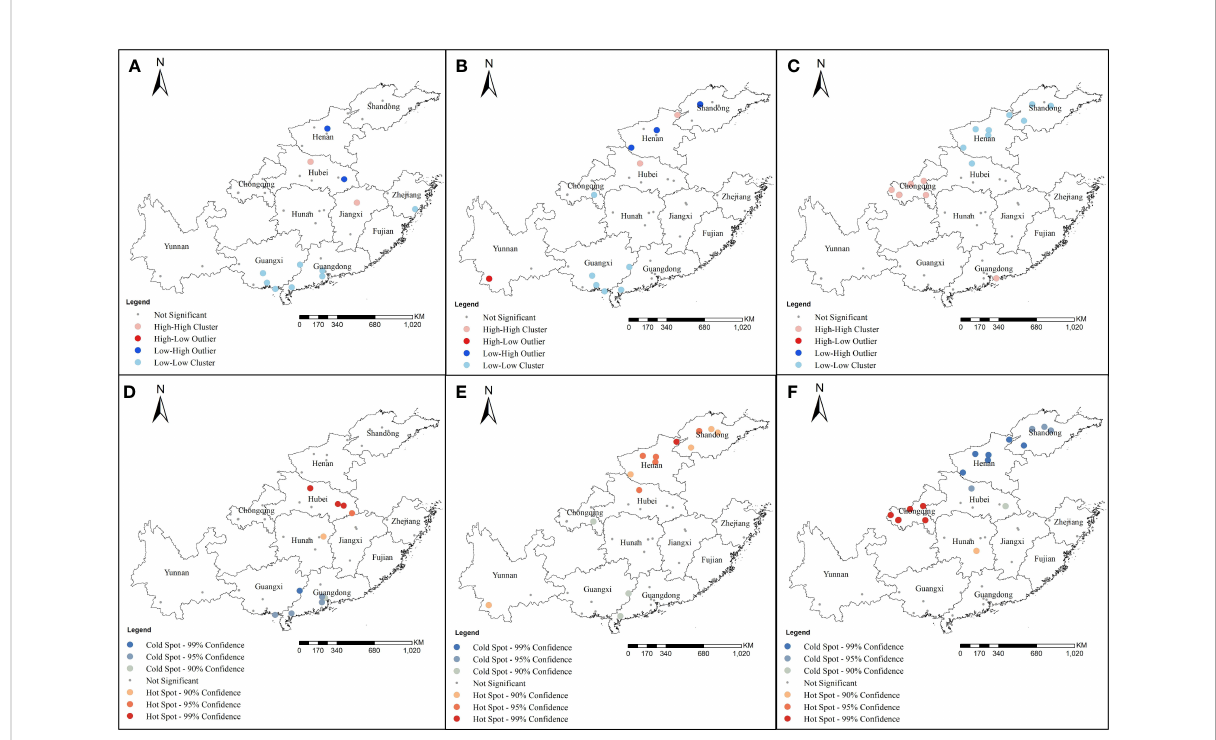
FIGURE 6 Local spatial autocorrelation for mutation rates of different codons of Ae. albopictus VGSC gene in 2020 at 49 sample collection sites from 11 provinces. (A) and (D) were the results of the Cluster and outlier analysis (Anselin Local Morans I ) and Hot Spot analysis (Getis-Ord Gi*) at codon 1016 of Ae. albopictus VGSC gene; (B) and (E) were the results of the Cluster and outlier analysis (Anselin Local Morans I ) and Hot Spot analysis (Getis-Ord Gi*) at codon 1532 of Ae. albopictus VGSC gene; (C) and (F) were the results of the Cluster and outlier analysis (Anselin Local Morans I ) and Hot Spot anal-ysis (Getis-Ord Gi*) at codon 1534 of Ae. albopictus VGSC